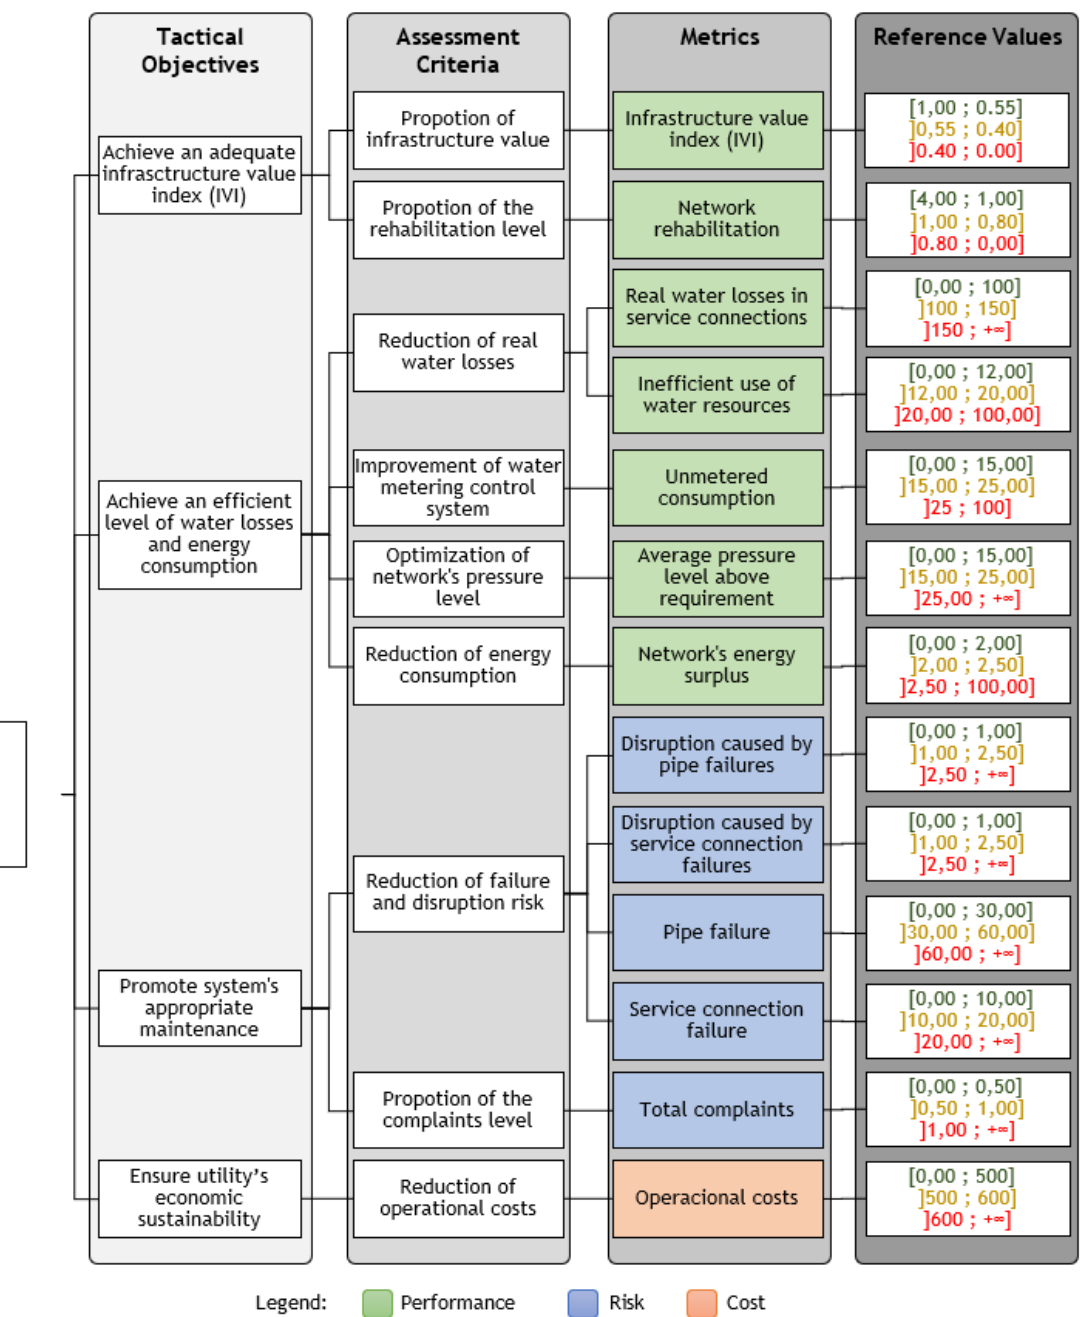
Figure 6: Alignment between tactical objectives, assessment criteria and metrics.